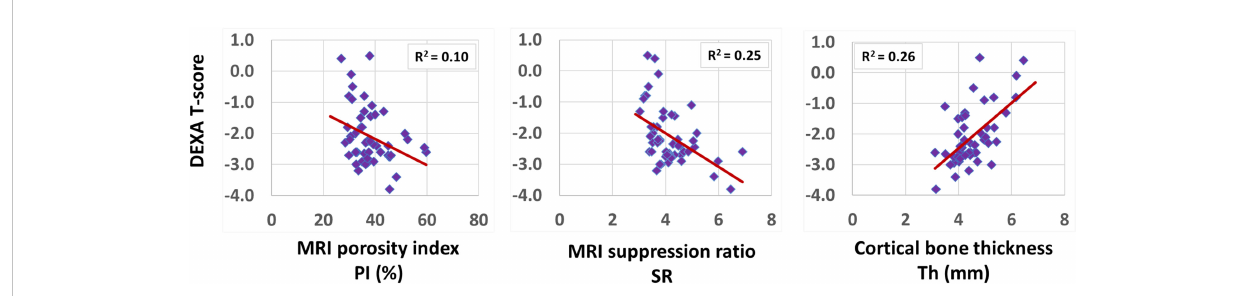
FIGURE 3 Scatterplots and linear trendlines of DEXA T-score on PI, SR, and bone thickness. R 2 values were calculated from Spearman ’ s correlation coef fi